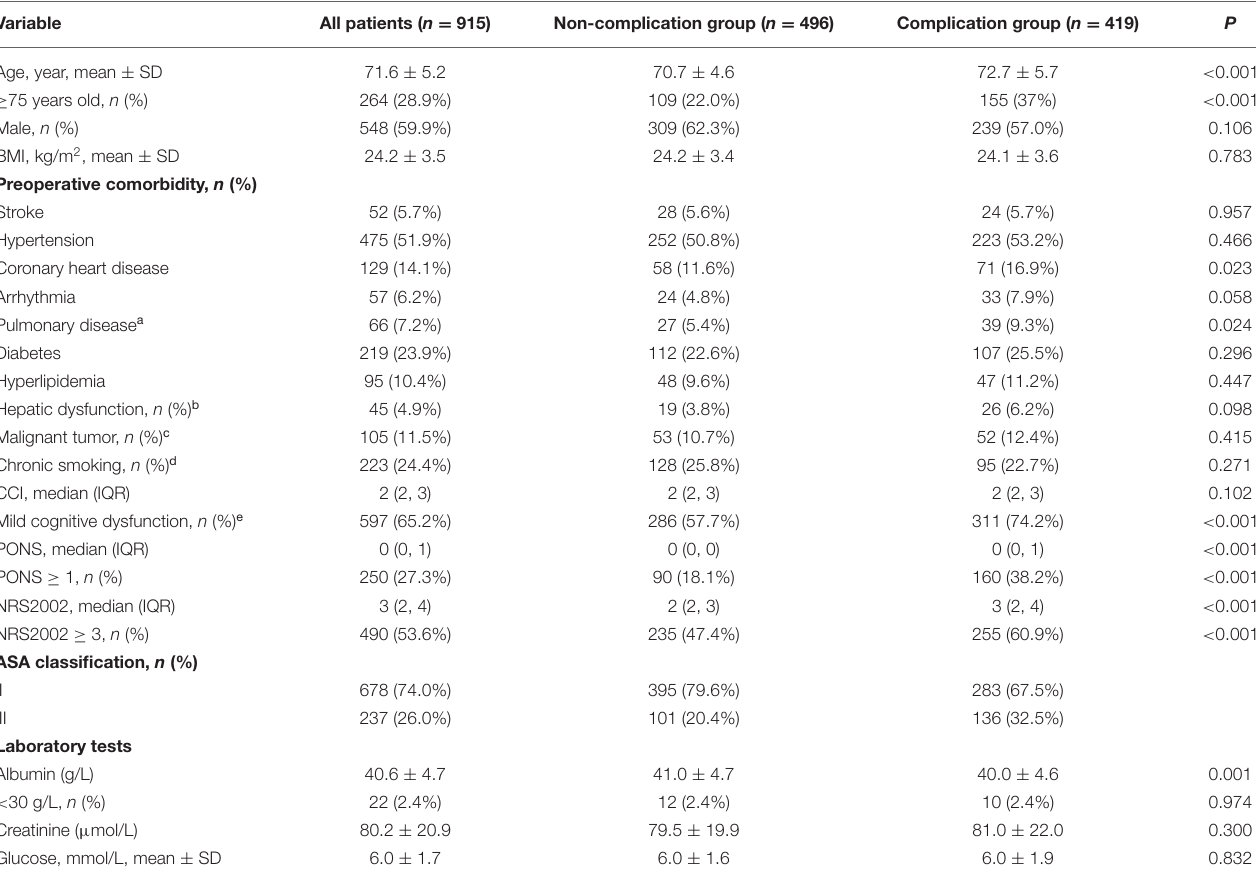
TABLE 2 | Baseline